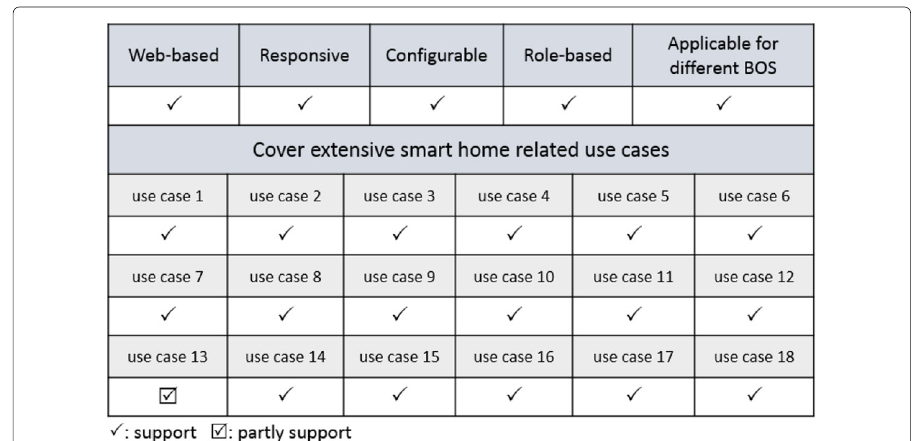
Fig. 25 Evaluation results for the design of the BOS